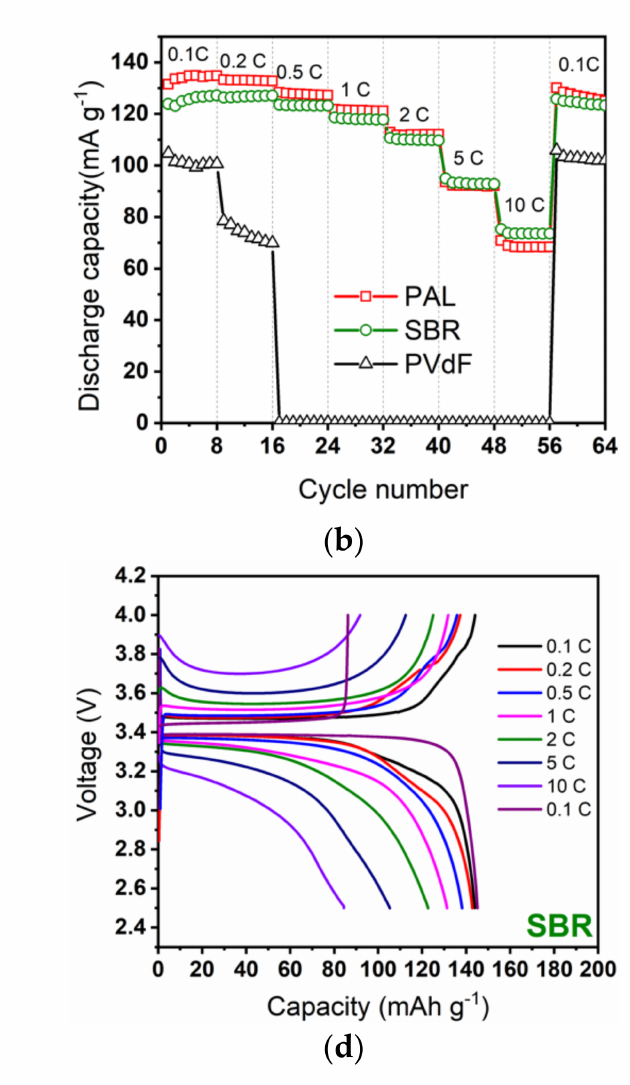
Figure 5. Electrochemical performance of the electrodes containing different binders: ( a ) long-term cycling, ( b ) rate capability. ( c , d ) are the voltage-capacity profiles of the electrodes at various